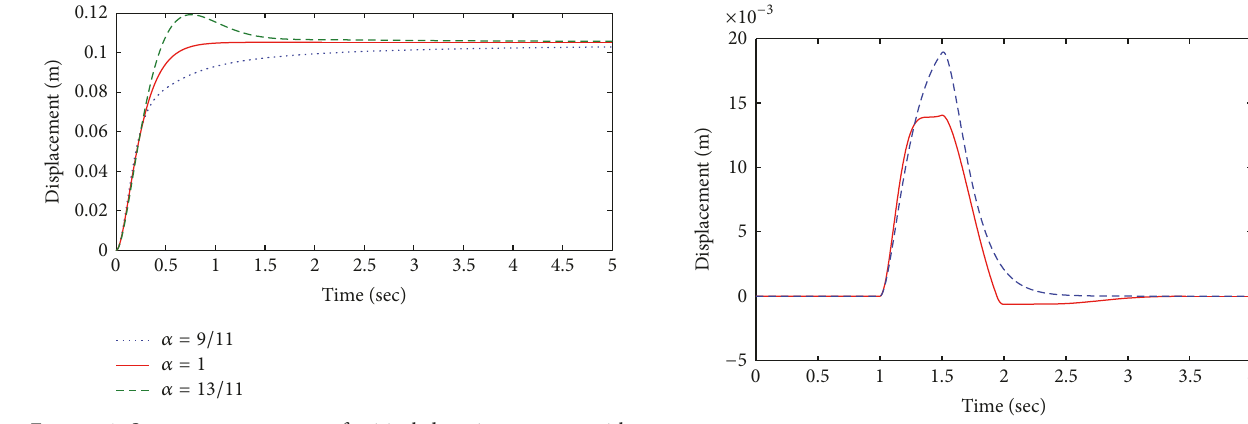
Figure 4: Step response curves of critical damping systems with different orders.